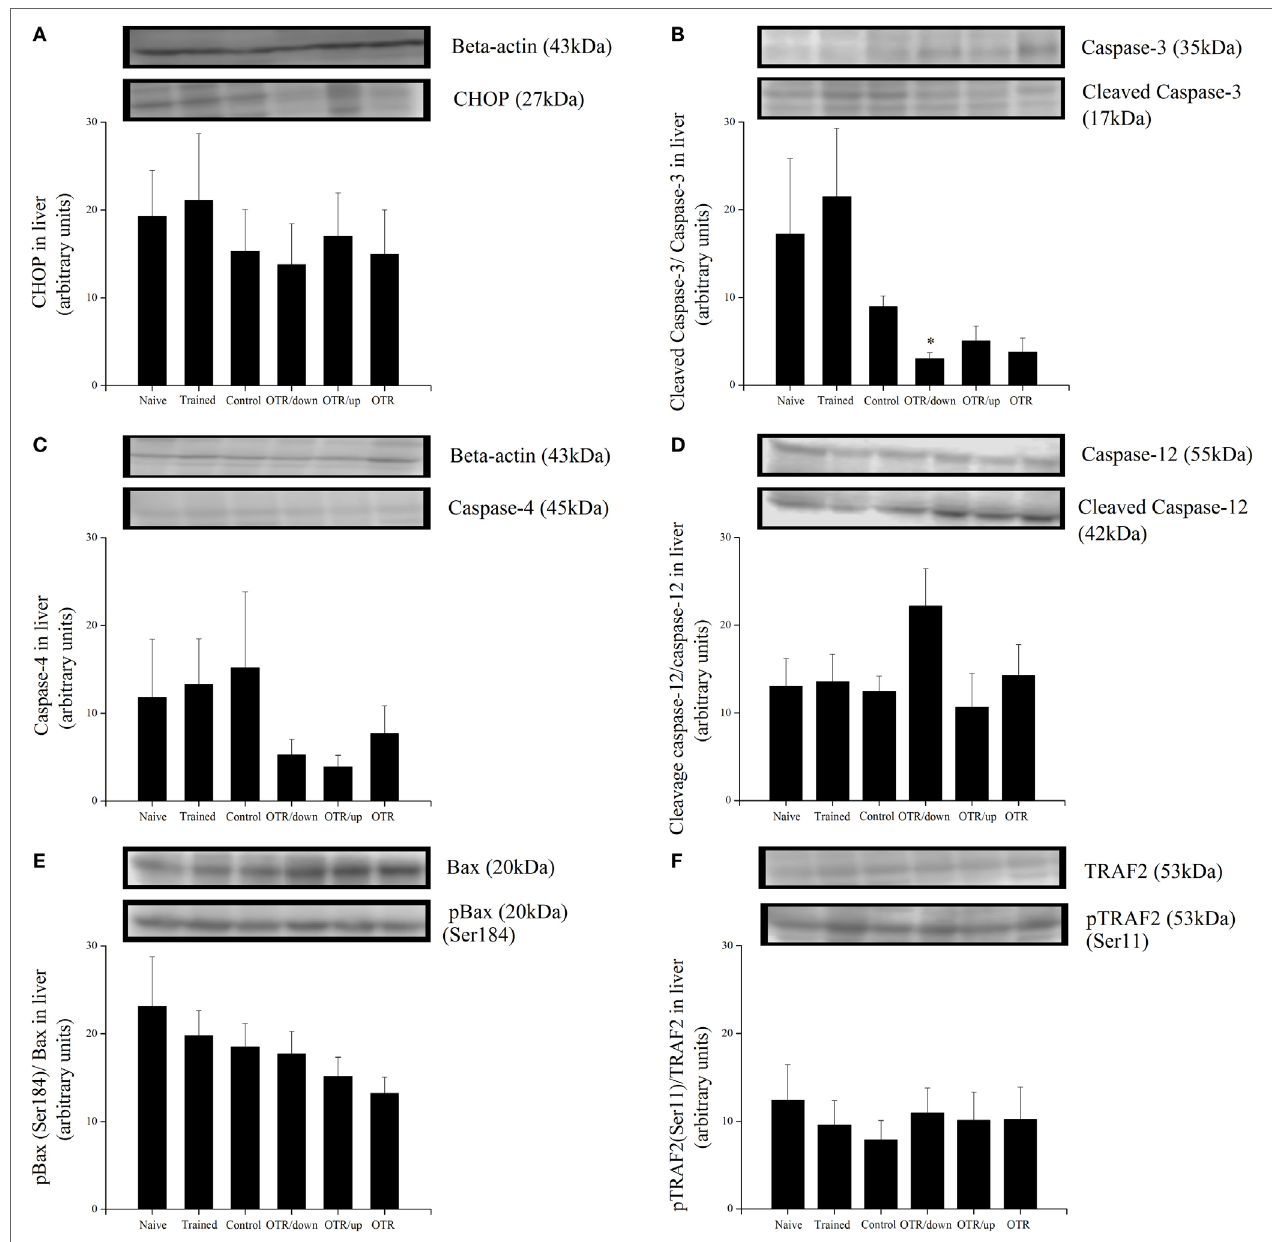
FigUre 3 | Protein levels (arbitrary units) of C/EBP-homologous protein (CHOP) (a) , Cleaved Caspase-3/Caspase-3 (b) , Caspase-4 (c) , Cleaved Caspase-12/ Caspase-12 (D) , pBax (Ser184)/Bax (e) , and pTRAF2 (Ser11)/tumor necrosis factor receptor-associated factor 2 (TRAF2) (F) in the livers of experimental animals. Data are expressed as the mean ± SE of n = 6 mice. N, sedentary mice; TR, trained mice; CT, sedentary mice; OTR/down, overtrained by downhill running; OTR/ up, overtrained by uphill running; OTR, overtrained by running without inclination. * P < 0.05 vs. CT group. The original experiments are available in supplementary file 3 (i.e., pBax and Bax), file 4 (i.e., Cleaved Caspase-12 and Caspase-12), file 5 (i.e., Cleaved Caspase-3 and Caspase-3), file 6 (i.e., Caspase-4), file 7 (i.e., pTRAF2), and file 8 (i.e., CHOP and